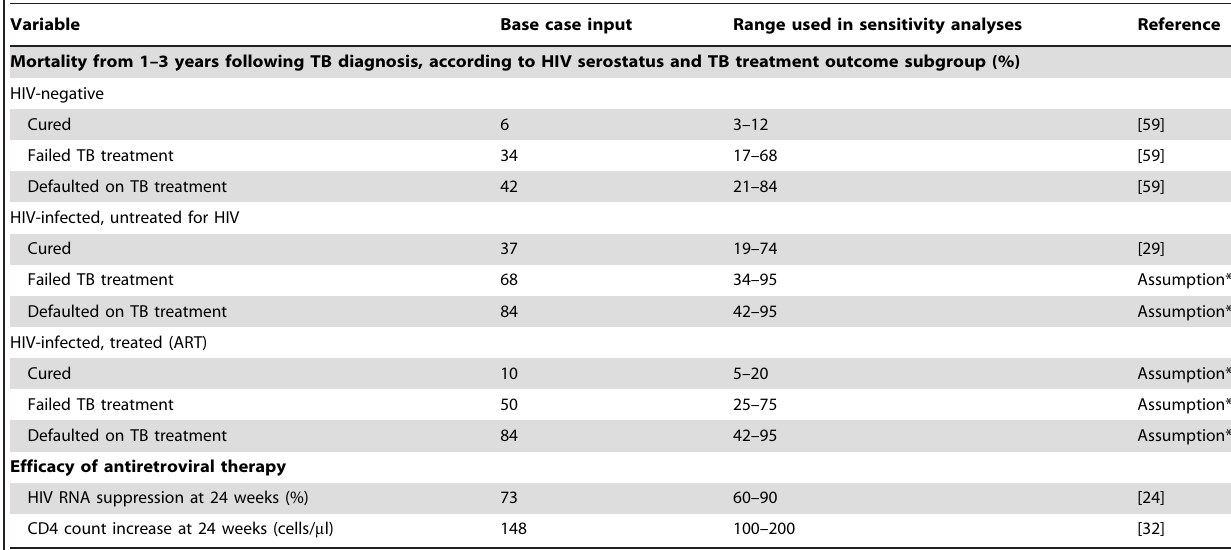
Table 2. TB mortality and ART efficacy model inputs for an analysis of HIV testing for TB patients in India.